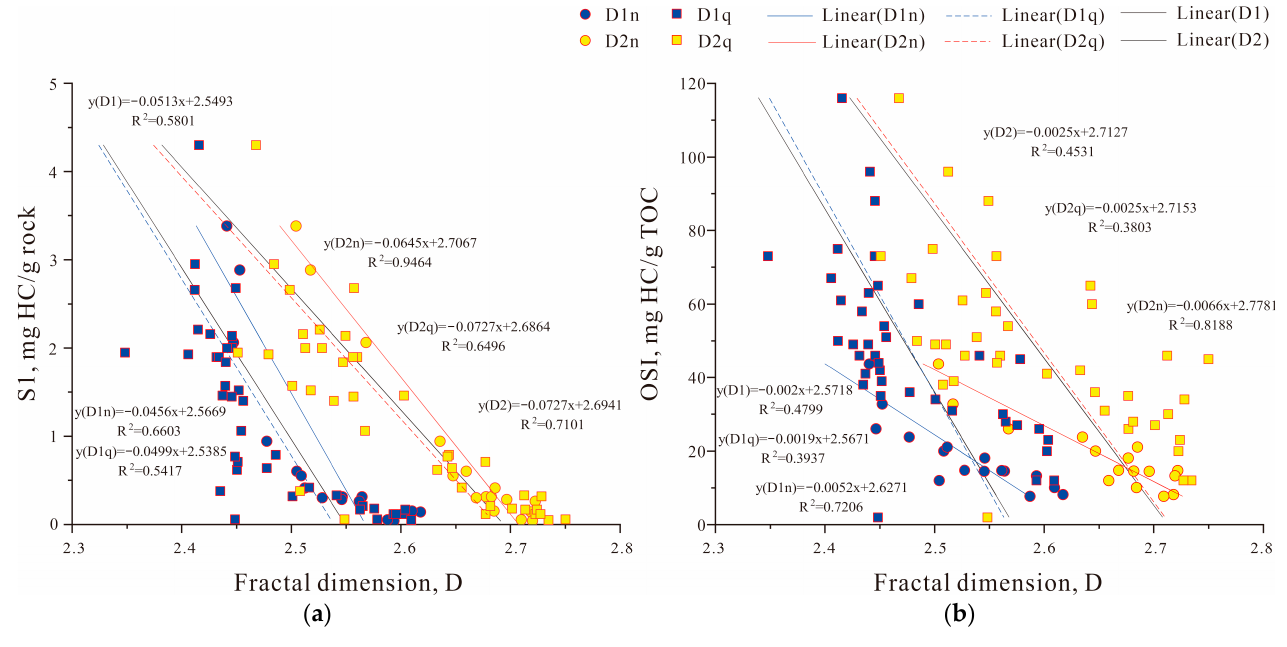
Figure 11. Relationship between fractal dimensions and oil content of K 2 n 1+2 and K 2 q shale samples, ( a ) for S1; ( b ) for OSI. The K 2 q compared to [78].